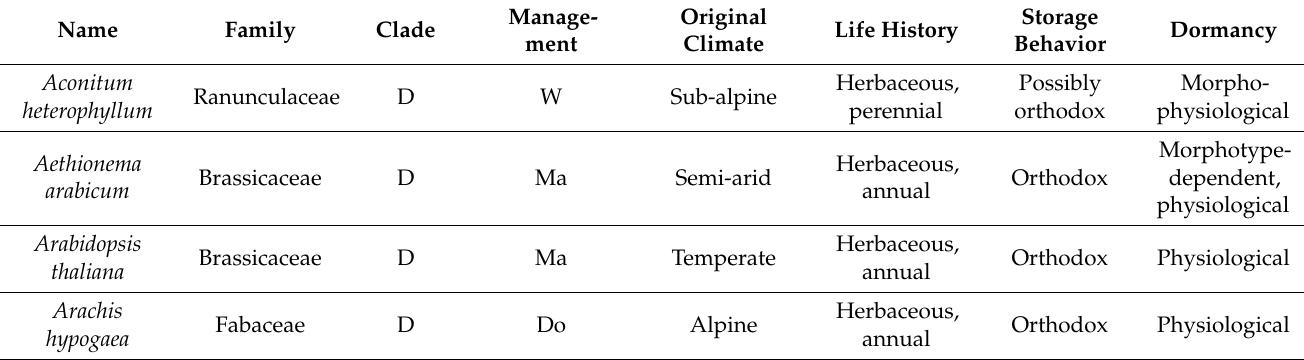
Table 2. Origin and management of the studied species reported in this review. Abbreviations: D, dicotyledons; G, gymnosperms; M, monocotyledons; Cu, cultivated; Do, domesticated; Ma, managed; W, wild; PHS, preharvest